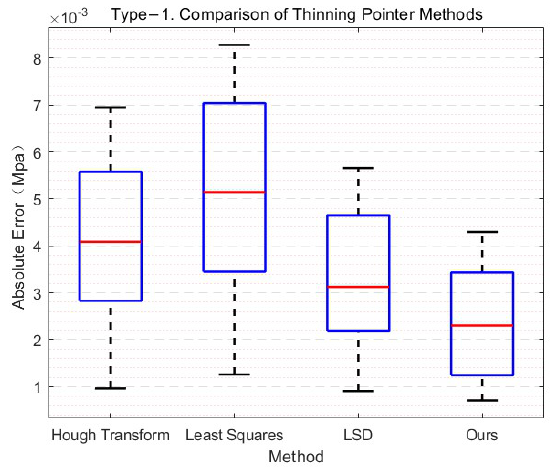
Figure 10. Refined needle method performance comparison. Figure 10. [M716][wk17] Refined needle method performance comparison.